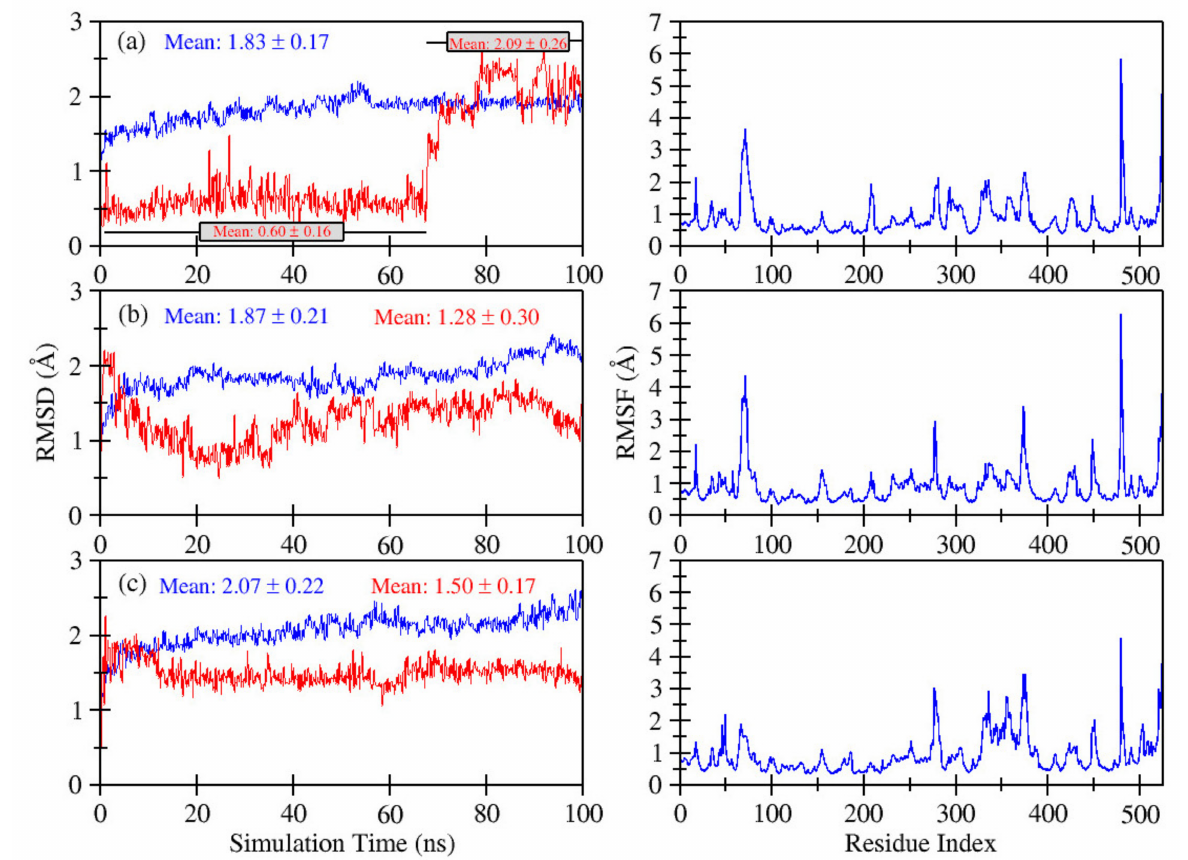
Figure 4. MD simulation interaction diagrams of 100 ns trajectory showing RMSD plot of kaempferol/ α - glucosidase ( a ), gallic acid/ α -glucosidase complex ( b ) and acarbose/ α a-glucosidase ( c ). RMSF tra- jectory plot of kaempferol/ α -glucosidase ( a ), gallic acid/ α -glucosidase complex ( b ) and acarbose/ α - glucosidase ( c ),